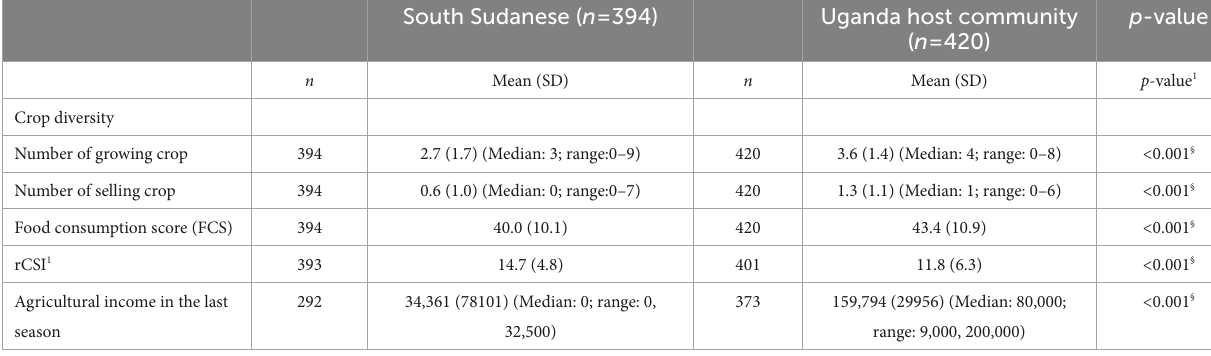
TABLE 3 crop diversity, food consumption score, reduced coping strategy index, and agriculture